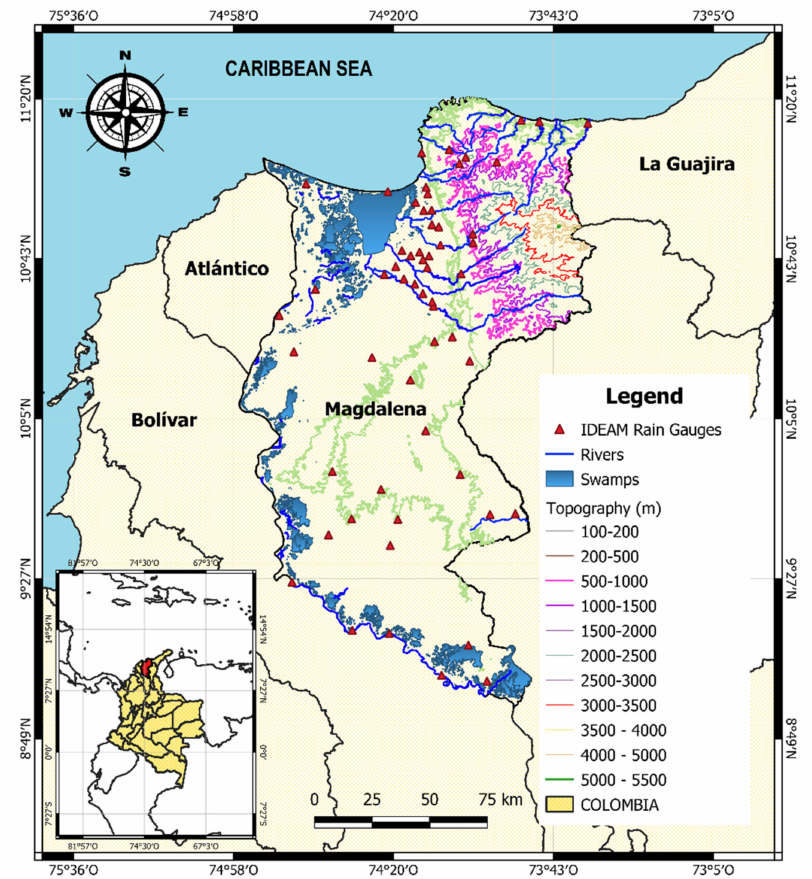
Figure 1. Magdalena Department and geographical distribution of the 59 analyzed meteorological stations (red triangles) directed and supervised by the Institute of Hydrology, Meteorology, and Environmental Studies (IDEAM). Main rivers in Sierra Nevada de Santa Marta (west side, from north to south: Manzanares, Gaura, Fr í o, Sevilla, Tucurinca, Aracataca, and Fundaci ó n. North side, from west to east: Piedras, Mendihuaca, Guachaca, Buritaca, and Don Diego). Additionally, wetland systems that are part or flood plain of Magdalena River are showing. From north to south they are: Ci é naga Grande de Santa Marta, Cerro de San Antonio, Zapay á n, Z á rate-Malib ú , Pijiño del Carmen, Rinconada, Chilloa, and